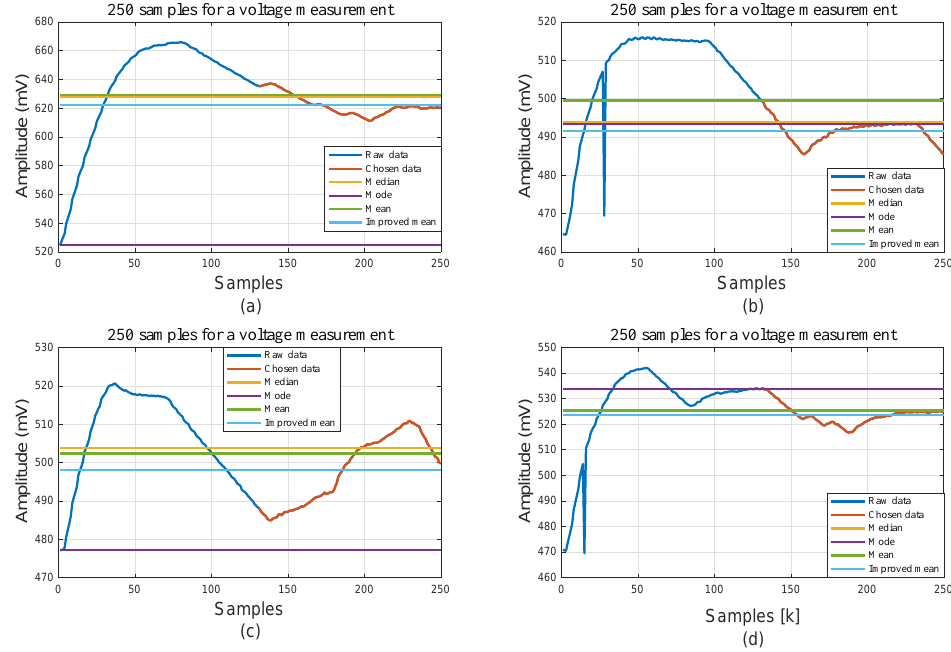
Figure 10. Four graphics showing measurements for four different electrode pairs, taken with the proposed EIT system by acquiring 250 samples. A transient voltage behavior is observed. ( a ) First pair of electrodes, ( b ) Second pair of electrodes, ( c ) Third pair of electrodes, and ( d ) Fourth pair of